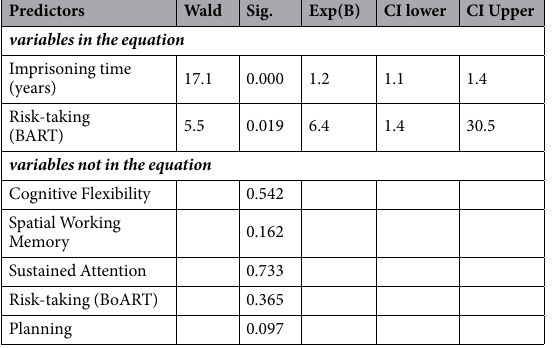
Table 2. Regression analysis